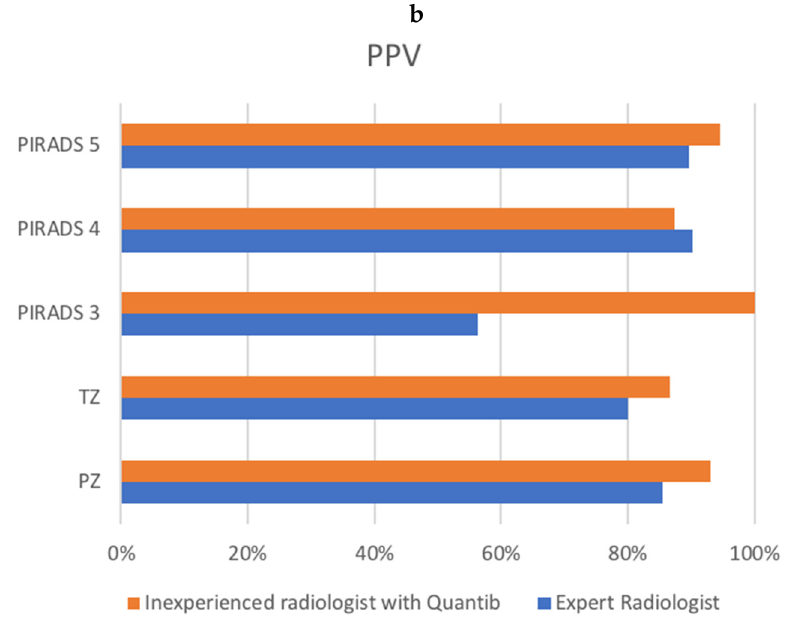
Figure 2. Comparison of sensitivity ( a ) and PPV ( b ) between the radiologist and the AI-assisted inexperienced radiologist, for groups A and B combined. X -axis represents percentages. ( a ) shows ISUP on the y -axis, as well as transition zone (TZ) and peripheral zone (PZ) sensitivity. ( b ) shows PI-RADS v2.1 score, as well as transition zone (TZ) and peripheral zone (PZ) positive predictive value (PPV).